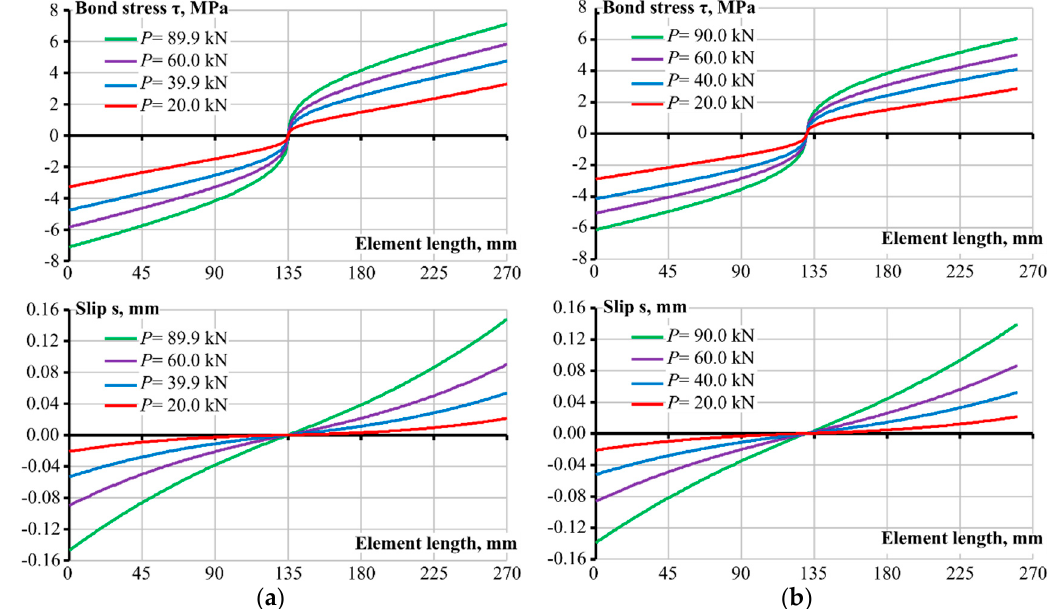
Figure 8. Estimated bond stress and slip distribution along the test specimens: ( a ) Strain gauge test and ( b ) FBG sensor test.